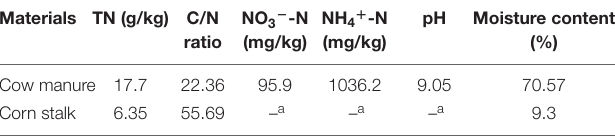
TABLE 1 | The physicochemical characteristics of the raw